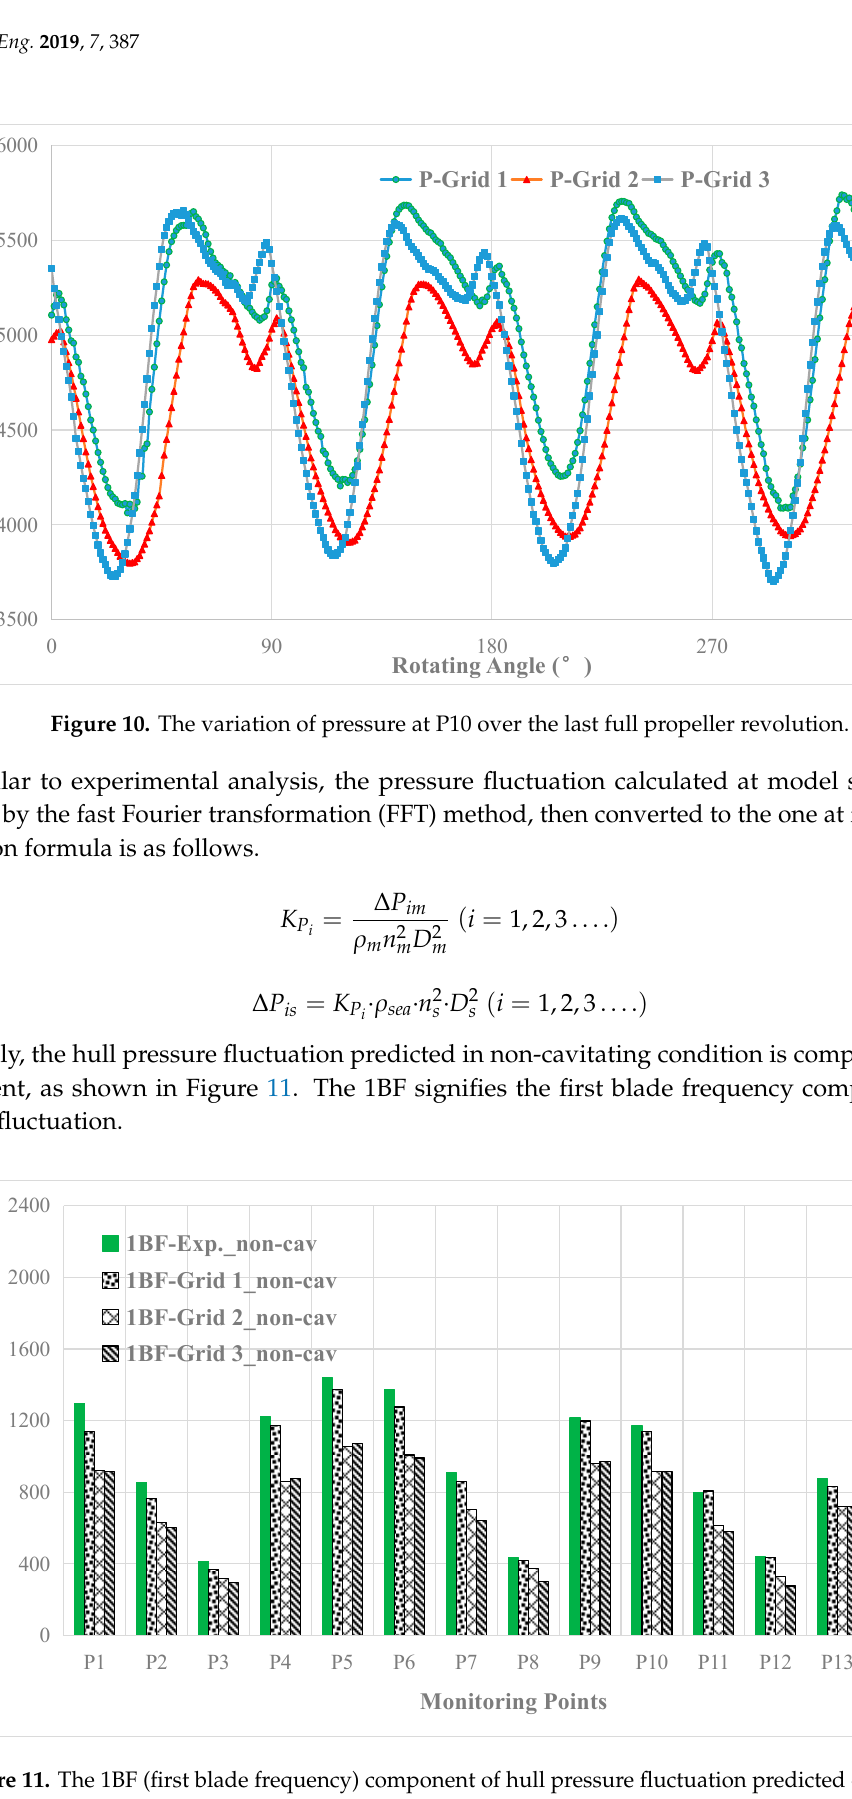
Figure 9. The arrangement of monitoring points.